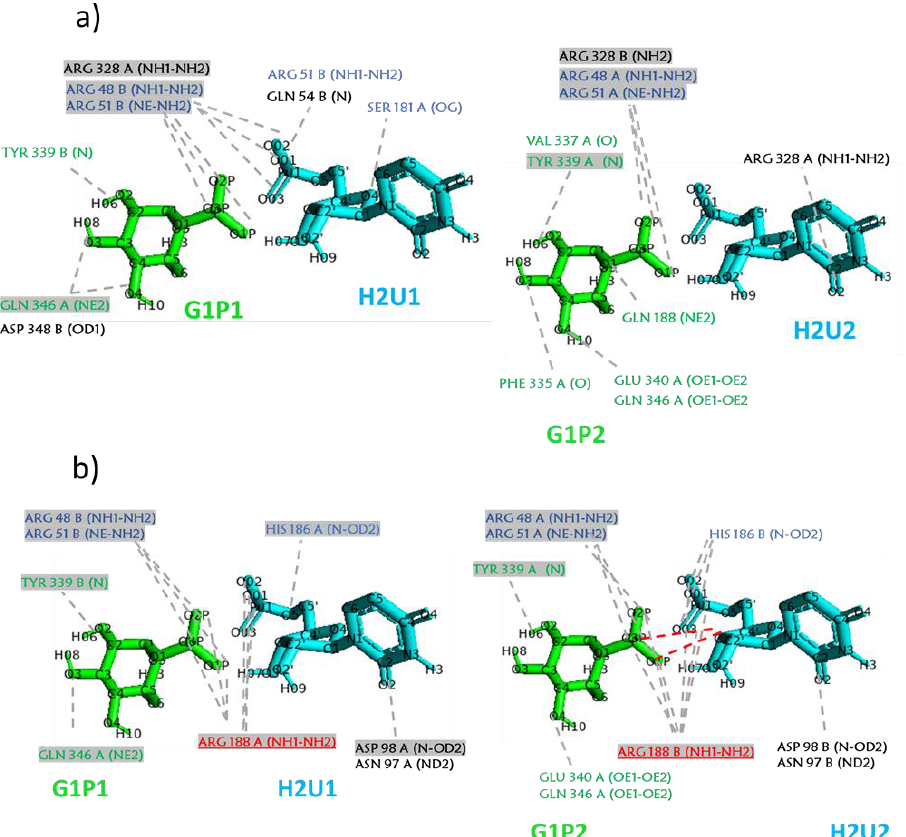
Figure 3. Interactions between enzyme and ligands in simulations at 310 K. ( a ) wtGALT; ( b ) p.Gln188Arg. Panels on the left indicate the ligands of the active site 1 (formally belonging to subunit A), panels on the right indicate the ligands of the active site 2 (formally belonging to subunit B). Grey background indicates interactions that persist for more than 50% of the simulation time. Grey dashed lines indicate H-bonds; residues underlined are also able to form salt bridges. Red dashed lines indicate interactions between the ligands.